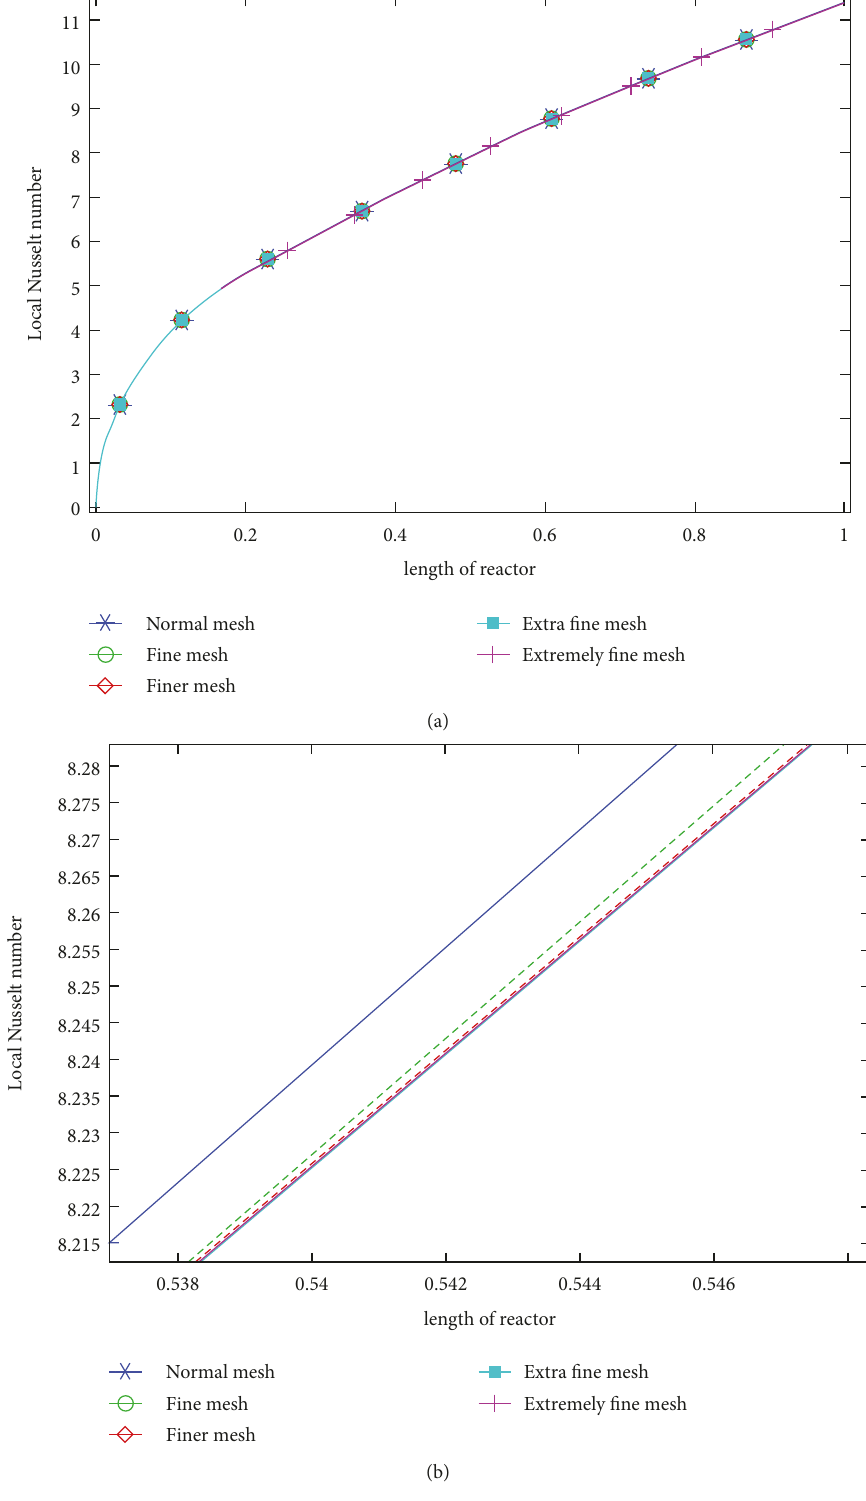
Figure 3: Numerical results gained with mesh independent study of the local Nusselt number. (a) Zoom-out; (b)